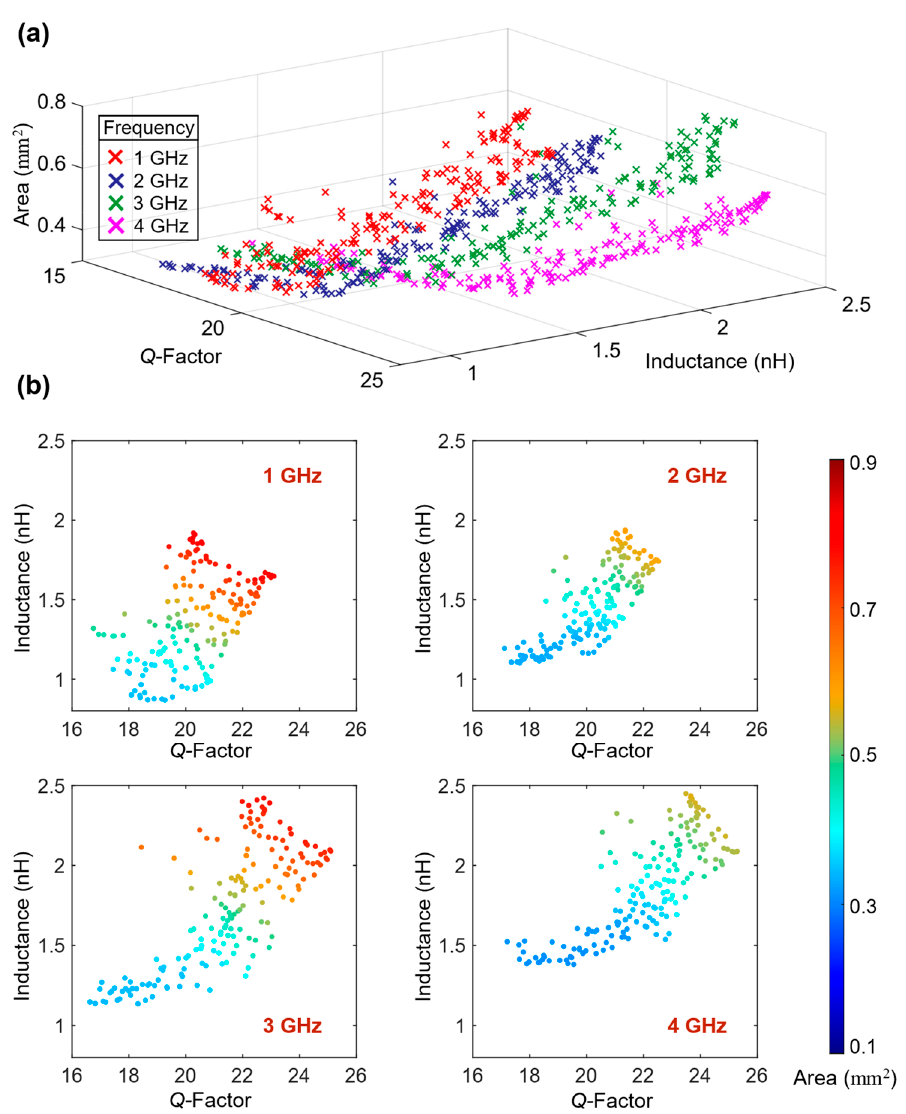
Figure 5. Pareto fronts for RF-MEMS inductor at four different frequencies between 1 and 5 GHz: ( a ) combined pareto plot for all frequencies; and ( b ) individual pareto plots at different frequencies.